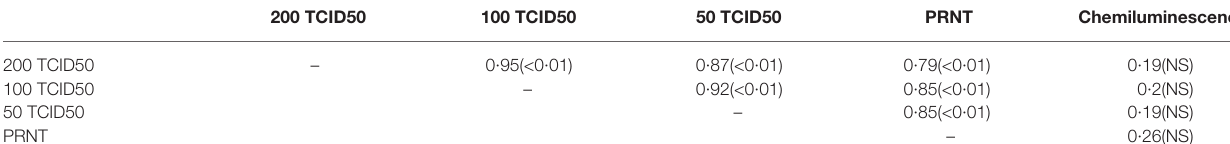
TABLE 3 | Spearman correlation coefficients and values of p resulting from comparisons of various assays.